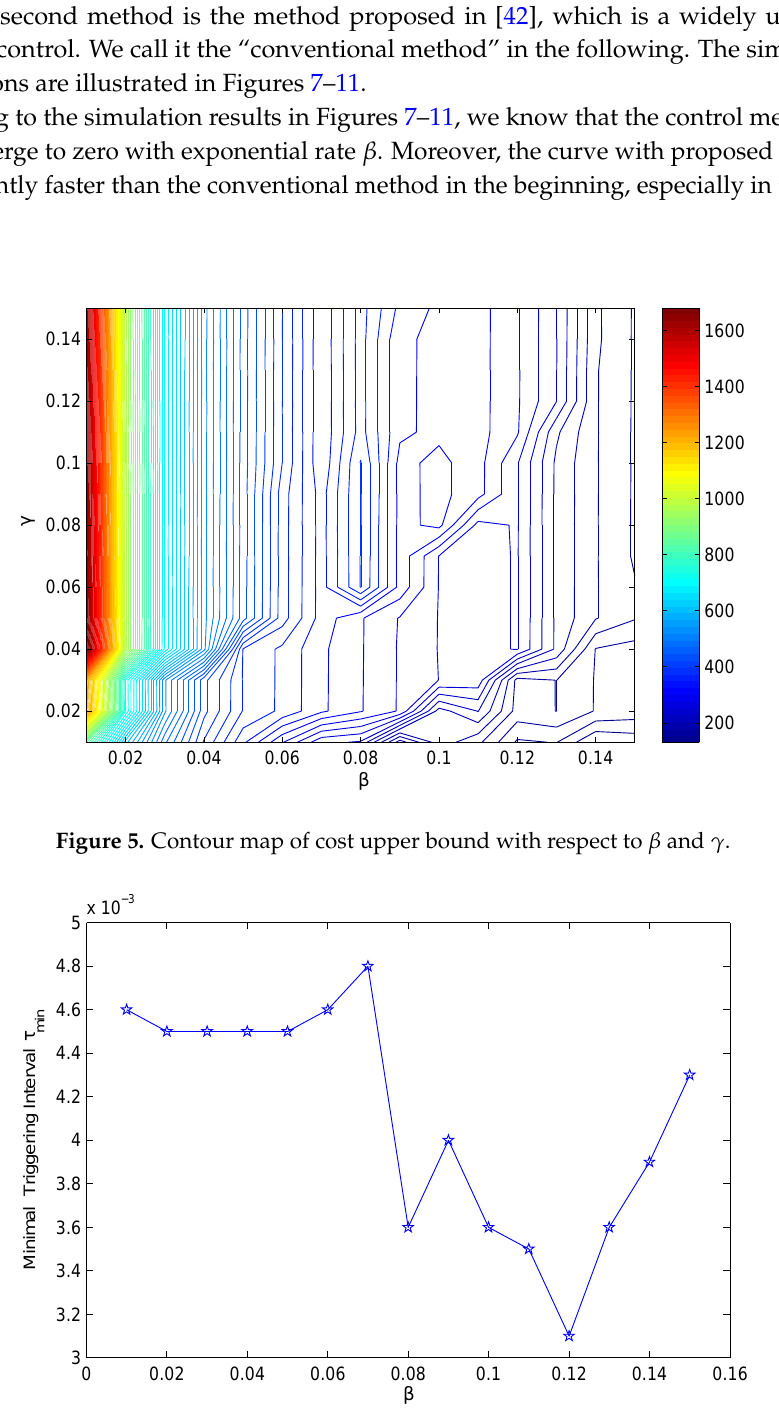
Figure 6. The minimal triggering interval curve with respect to β